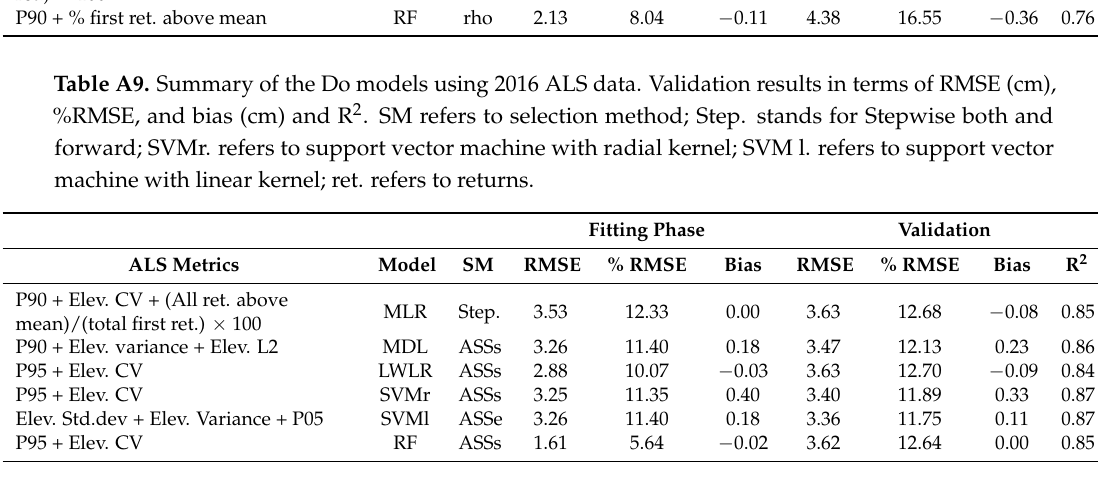
Table A10. Summary of the Ho models using 2011 ALS data. Validation results in terms of RMSE (m), %RMSE, and bias (m) and R 2 . SM refers to selection method; Step. stands for Stepwise both and forward; SVMr. refers to Support Vector Machine with radial kernel; SVM l. refers to Support Vector Machine with linear kernel; ret. refers to